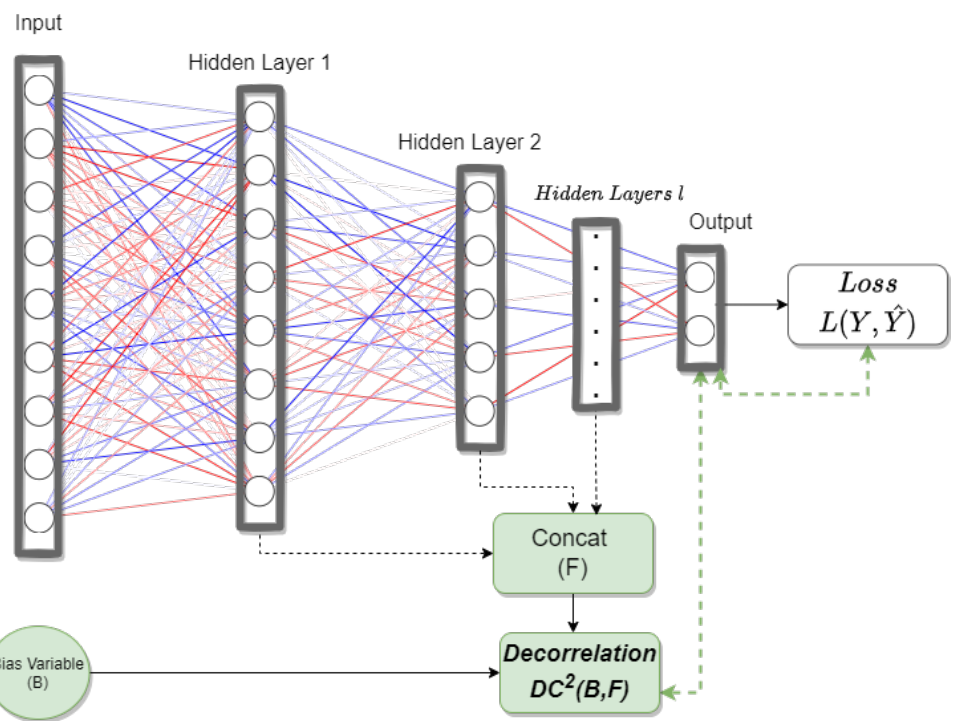
Figure 1. Proposed DcANN architecture: Black dashed lines denote the output of hidden layers l which are combined together to represent learned features. Green dashed lines indicate the start of the learning process where backward arrows show back-propagation using their respective gradient values while forward arrows show forward paths with updated parameters. Network parameters are updated as per the objective function.